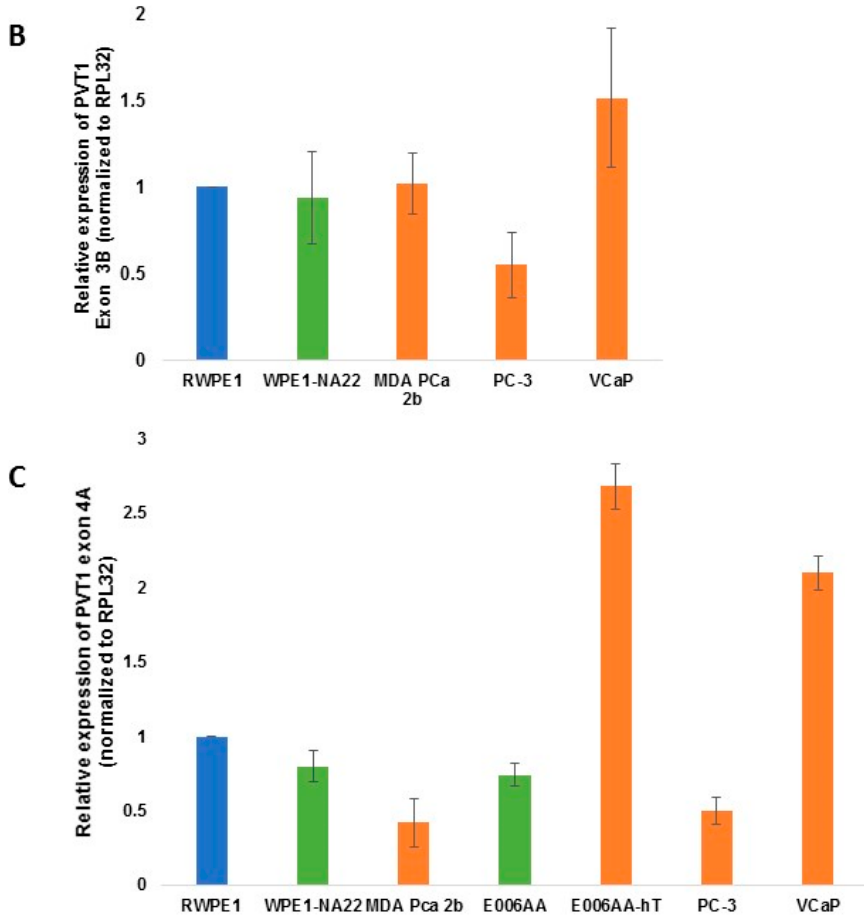
Figure 3. PVT1 exons 2 ( A ); 3b ( B ); and 4a ( C ) expression in non-tumorigenic and tumorigenic prostate epithelial cell lines. Four (for exon 2 and exon 3b) or 3 (for exon 4a) independent qPCR experiments were performed and every experiment was set up in quadruplicates. The data showed that there is no significant differential expression of the exons in the cell lines in comparing cell lines derived from CM with those derived from MoAA. The data are presented as mean + standard error of the mean (SEM). For PVT1 exons 4b, 5, 6 (Figure 4), 7 and 8 (Figure 5), there were no differential expression observed in comparing MDA PCa 2b to RWPE1.